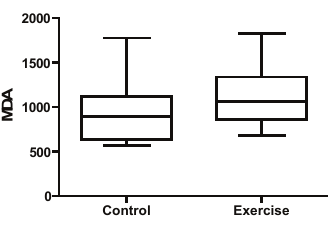
FIGURE 3 - Comparison of levels of MDA (ng/mL) in striated muscle between groups (Student t test; p=0.2835).